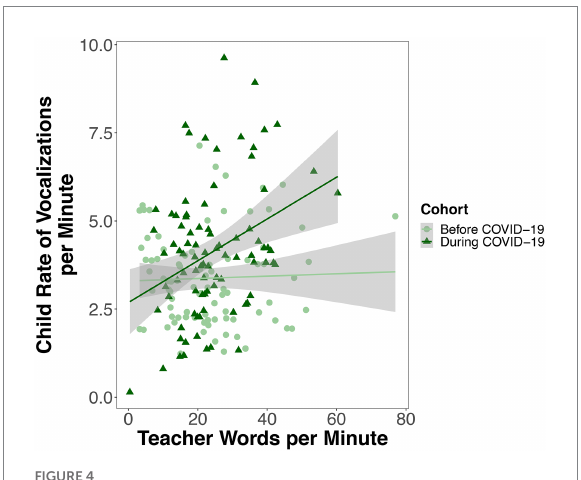
FIGURE 4 Each point represents one recording session for one child. Rate variables are expressed as number of child vocalizations or teacher words per minute. For children observed during COVID-19 (but not before), the higher the rate of teacher words per minute children were exposed to, the higher the rate of vocalizations children produced